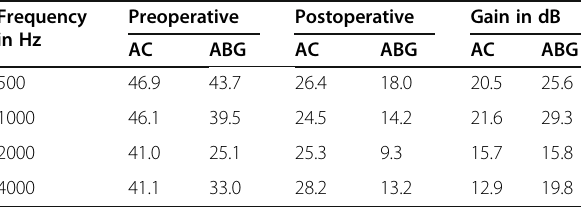
Table 2 Preoperative and postoperative air conduction (AC), air bone gap (ABG), and gains in dB, across different frequencies: 500, 1000, 2000, and 4000